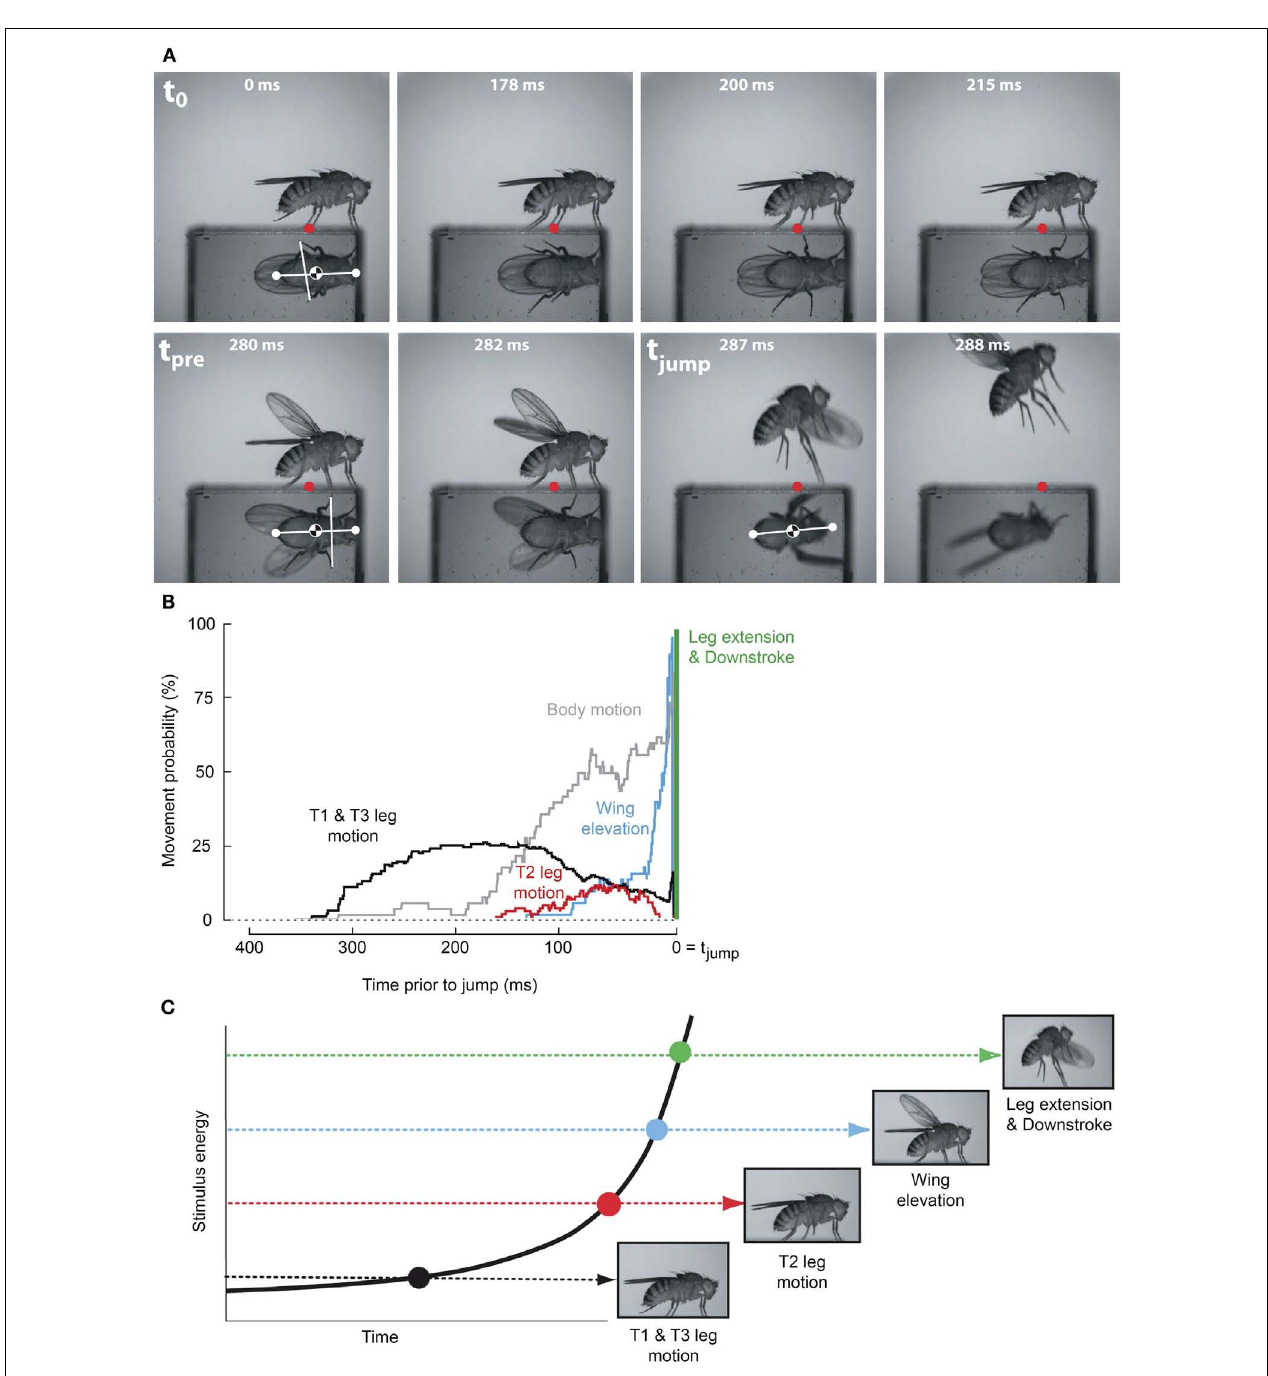
dots mark head and abdomen points. (B) Probability that body parts of the fly (black,T1 andT3 legs; red,T2 legs; blue, wings; gray, body) were moving prior to takeoff (green line). (C) As stimulus intensity increases, independent motor programs are activated eliciting discrete escape subbehaviors prior to takeoff. Adapted with permission from Card and Dickinson